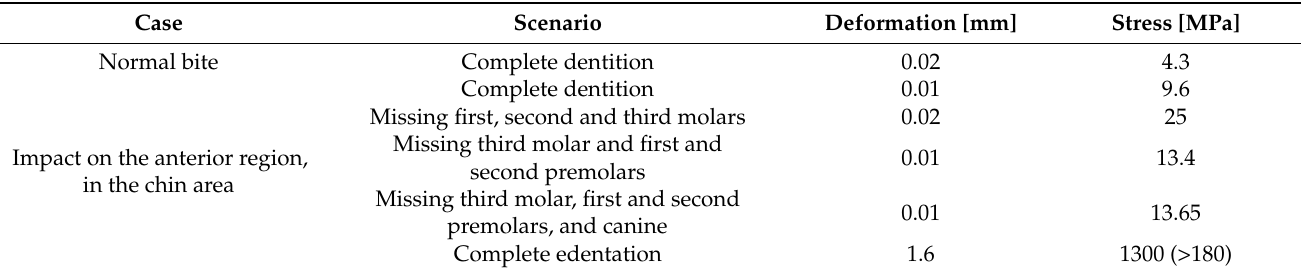
Table 1. Total deformation and equivalent stress on the surface of the condyle, in case of impact on the anterior face of the chin